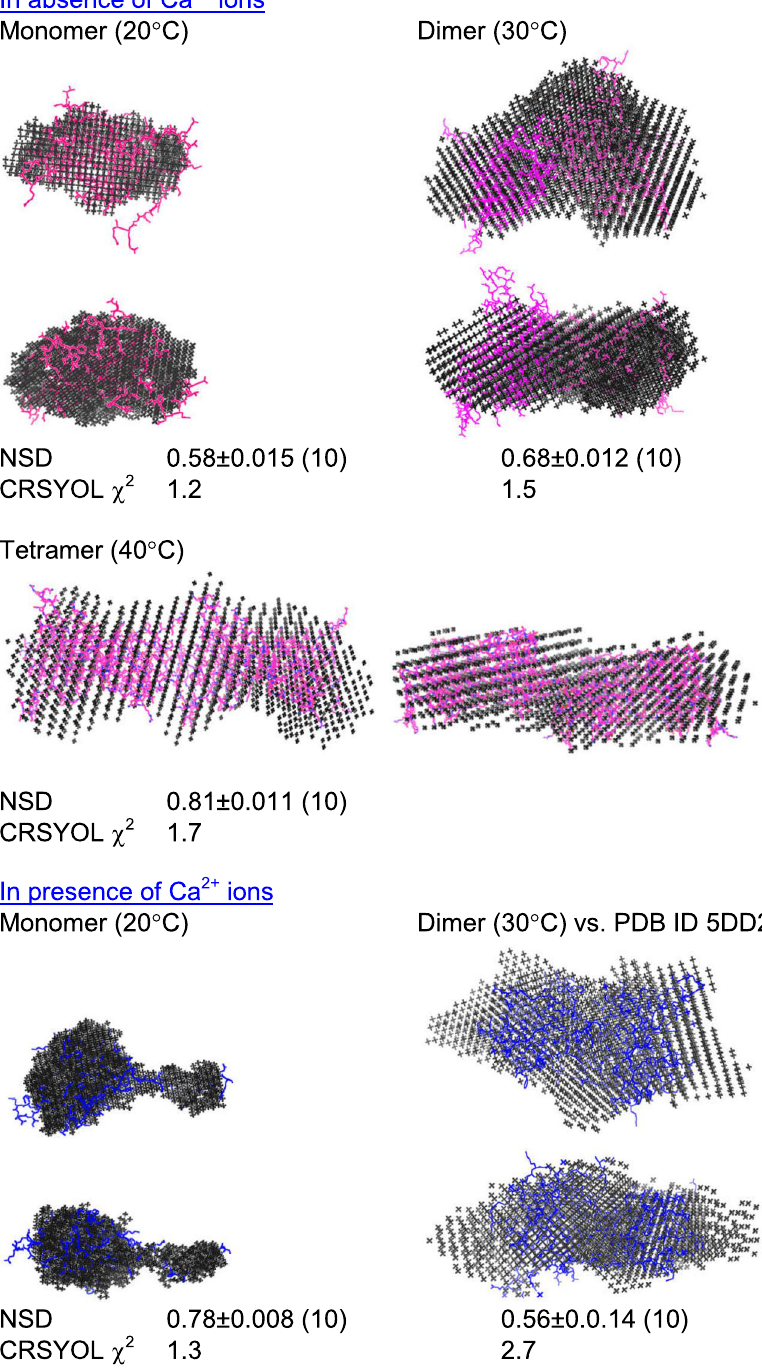
Figure 3. SAXS data based models are presented here. The conditions of the data collection are mentioned. SAXS data based dummy residue models are shown as grey spheres. The crystal structure or models superimposed on the SAXS data based models are shown as pink (EGTA conditions) and blue (Ca 2 + -activated) stick models. The NSD and χ 2 values are mentioned below the models. The value in parentheses of the NSD value indicated the number of models out of 10 which were used for